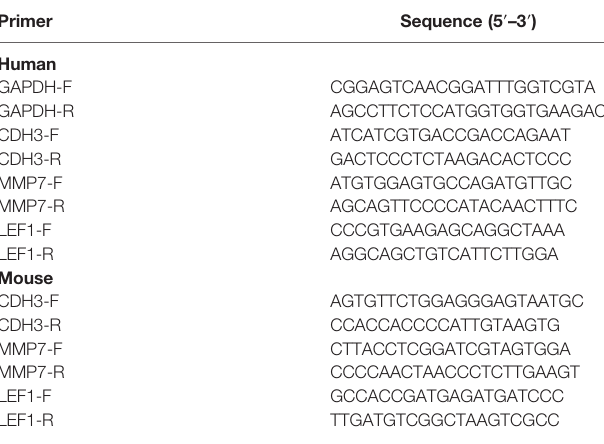
TABLE 1 | Primers and their sequences for PCR